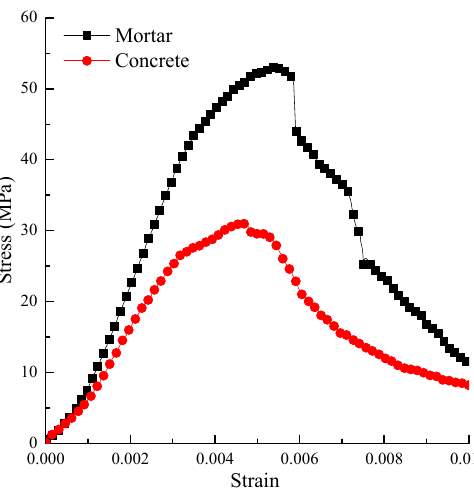
Figure 3. Stress–strain curve of the quasi-static test.